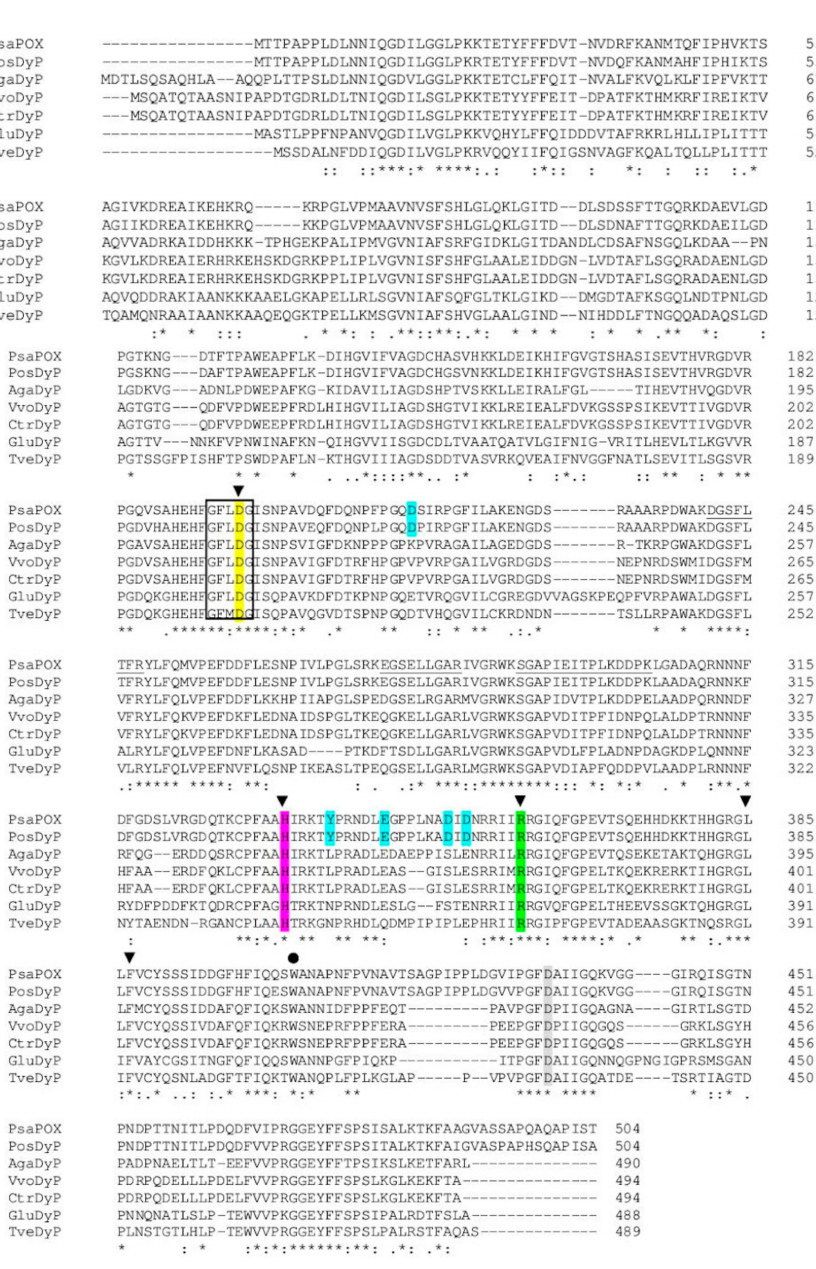
Figure 3. Alignment of alkene cleaving peroxidase from P. sapidus (PsaPOX) with the Pleos -DyP4 of P. ostreatus (PosDyP; KDQ22873.1) and other characterized DyPs. AgaDyP: Armillaria gallica (PBK80505.1), VvoDyP: Volvariella volvacea (AKU04643.1), CtrDyP: Coriolopsis trogii (AUW34346.1), GluDyP: Ganoderma lucidum (ADN05763.1), and TveDyP: Trametes versicolor (XP_008039377.1). Inverted triangles show amino acids important for heme binding (histidine (magenta) functions as ligand for heme and the four other amino acid residues form a hydrogen peroxide binding pocket). Aspartic acid, which forms a hydrogen bond with histidine to stabilize compound I (oxidized heme after transfer of two electrons to H 2 O 2 ) is shown in grey. The black box indicates the GXXDG motif containing the catalytic aspartic acid residue (yellow), which cleaves H 2 O 2 heterolytically with the help of the neighboring arginine (green) to form compound I, and the circle presents an exposed tryptophan potentially involved in an LRET (long range electron transfer). Important amino acids for Mn 2 + -oxidation are highlighted in cyan; asterisks indicate conserved residues, colons equivalent residues and dots partial residue conservation. Peptides identified by protein sequencing are